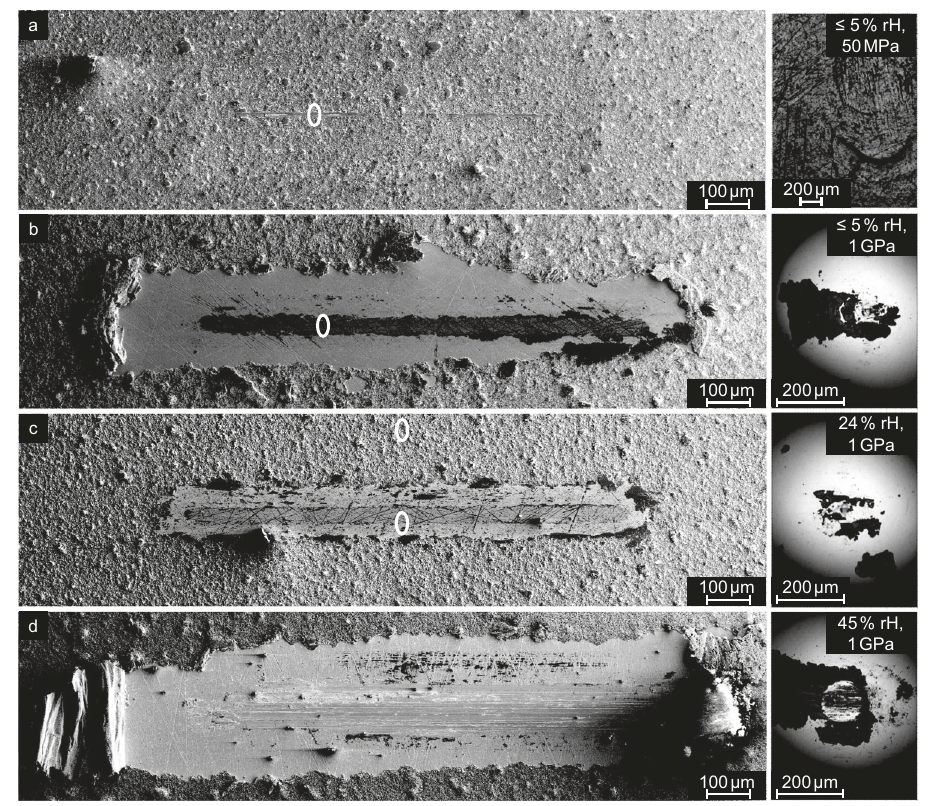
Fig.3|ScanningElectronMicroscopyimagesofweartracksandcounterbodies taken after microtribometer experiments at different pressure and humidity values. a ≤ 5% RH (dry pressurized air) at 50MPa, b ≤ 5%RH (drypressurized air) at